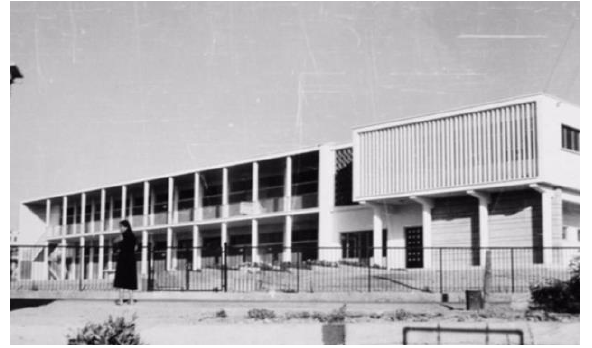
Figure 3. D. Thymopoulos, Lykavytos Elementary School, Nicosia, 1955- 57 (Pyla,Phokaides,